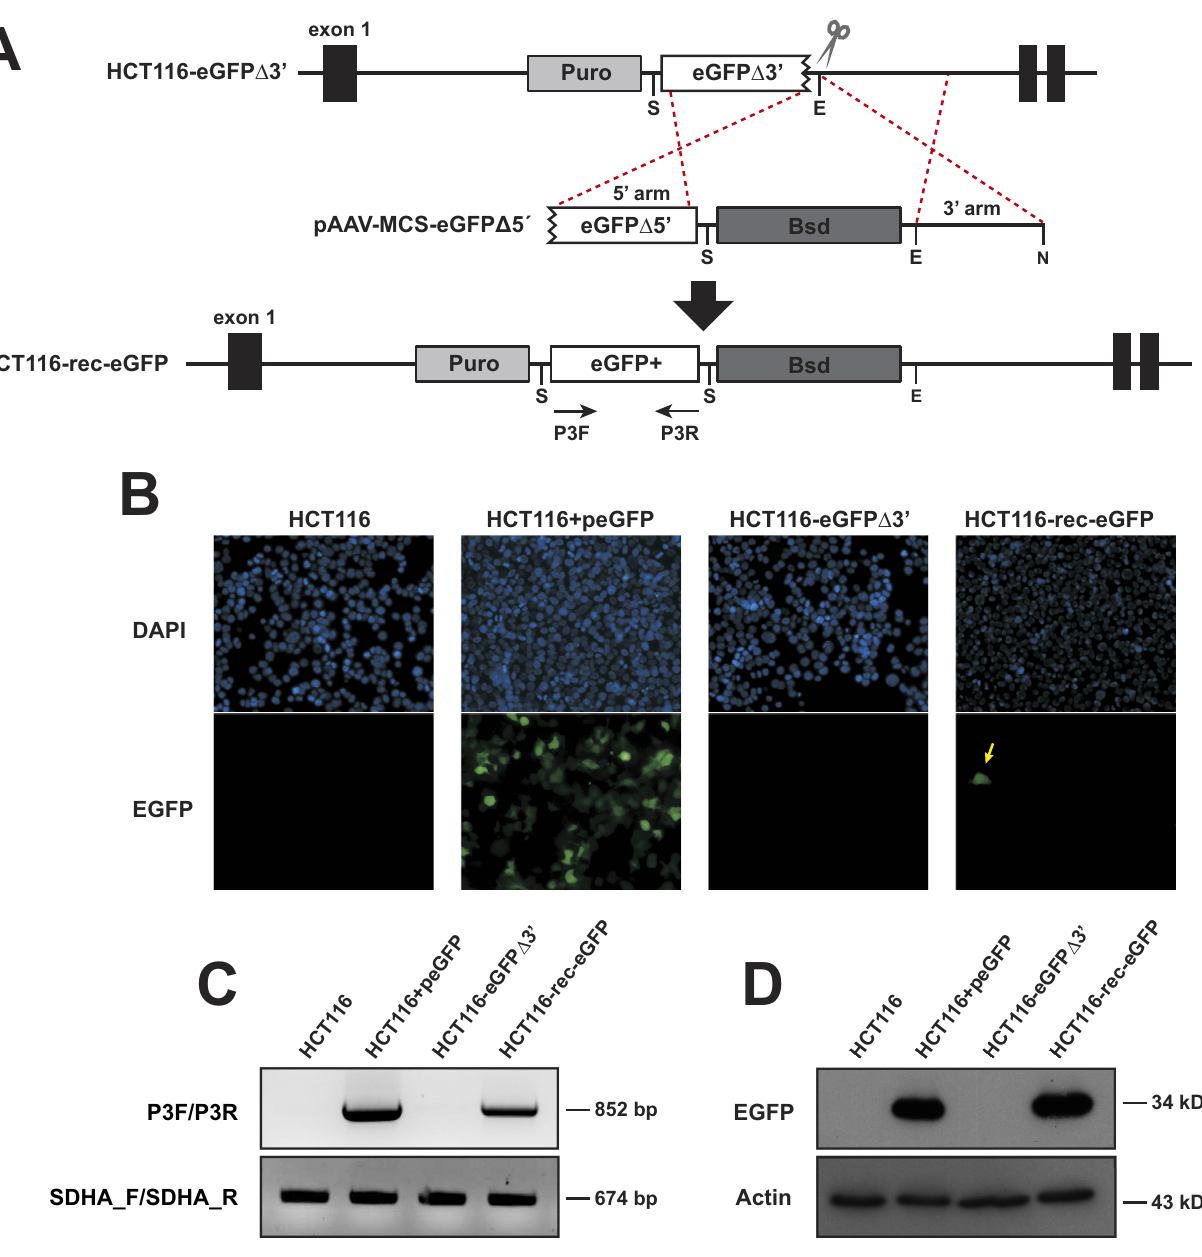
Fig 4. HR-mediated reconstitution of full-length eGFP. (A) Schematic illustration of HR-mediated eGFP reconstitution in the HCT116-eGFP Δ 3’ reporter cell line after infection with AAV particles containing donor plasmid pAAV-MCS-eGFP Δ 5’. Resultant eGFP+ cells are designated HCT116-rec-eGFP. (B) Fluorescent images of the indicated cell lines were captured using a 20x objective. The eGFP signal is shown in green and DAPI-stained nuclei are shown in blue. Parental HCT116+peGFP corresponds to wild type HCT116 transfected with a plasmid containing eGFP. The yellow arrow in the right panel depicts a HCT116-rec-eGFP cell. (C) PCR analysis for eGFP reconstitution with primer pairs P3F/P3R and hSDHA_F/hSDHA_R (for loading control). DNA was extracted from the indicated cell lines. HCT116-rec-eGFP refers to a single cell-derived clone. (D) Western blot analysis of total cell extracts from the same cells as in C using a polyclonal antibody against eGFP or β -actin (loading control).